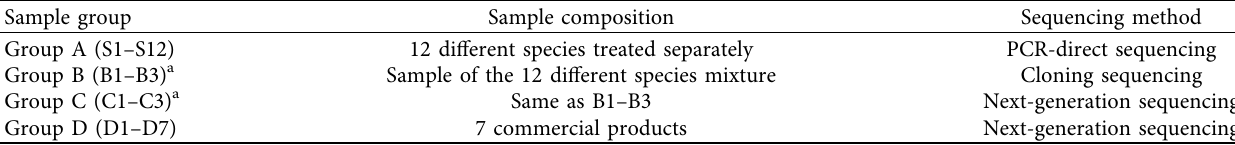
Table 1: The name, composition, and sequencing methods for each sample in the four groups (A, B, C, and D). Sample